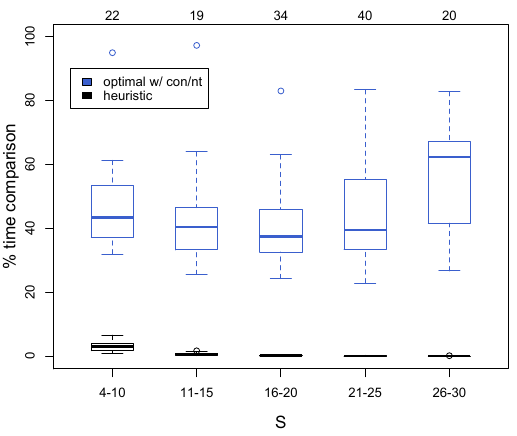
Figure 5. Time required by several solutions, as percentage fractions of the optimal solution time. Results are grouped by S . Top axis gives the number of network topology samples for each S